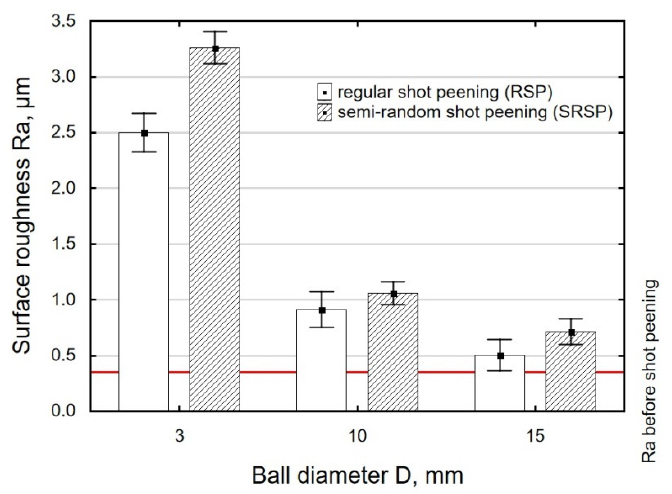
Figure 10. Shot-peening element diameter versus roughness parameter Ra (impact energy E = 100mJ, distance between dimples x = 0.3 mm).